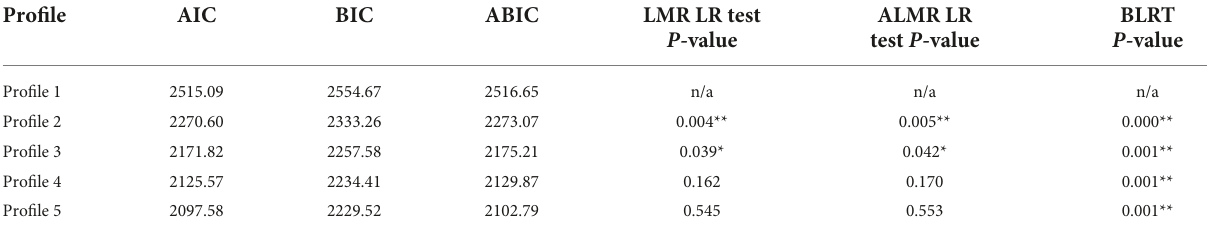
TABLE 4 Comparison of different job demands-resources latent profile analysis